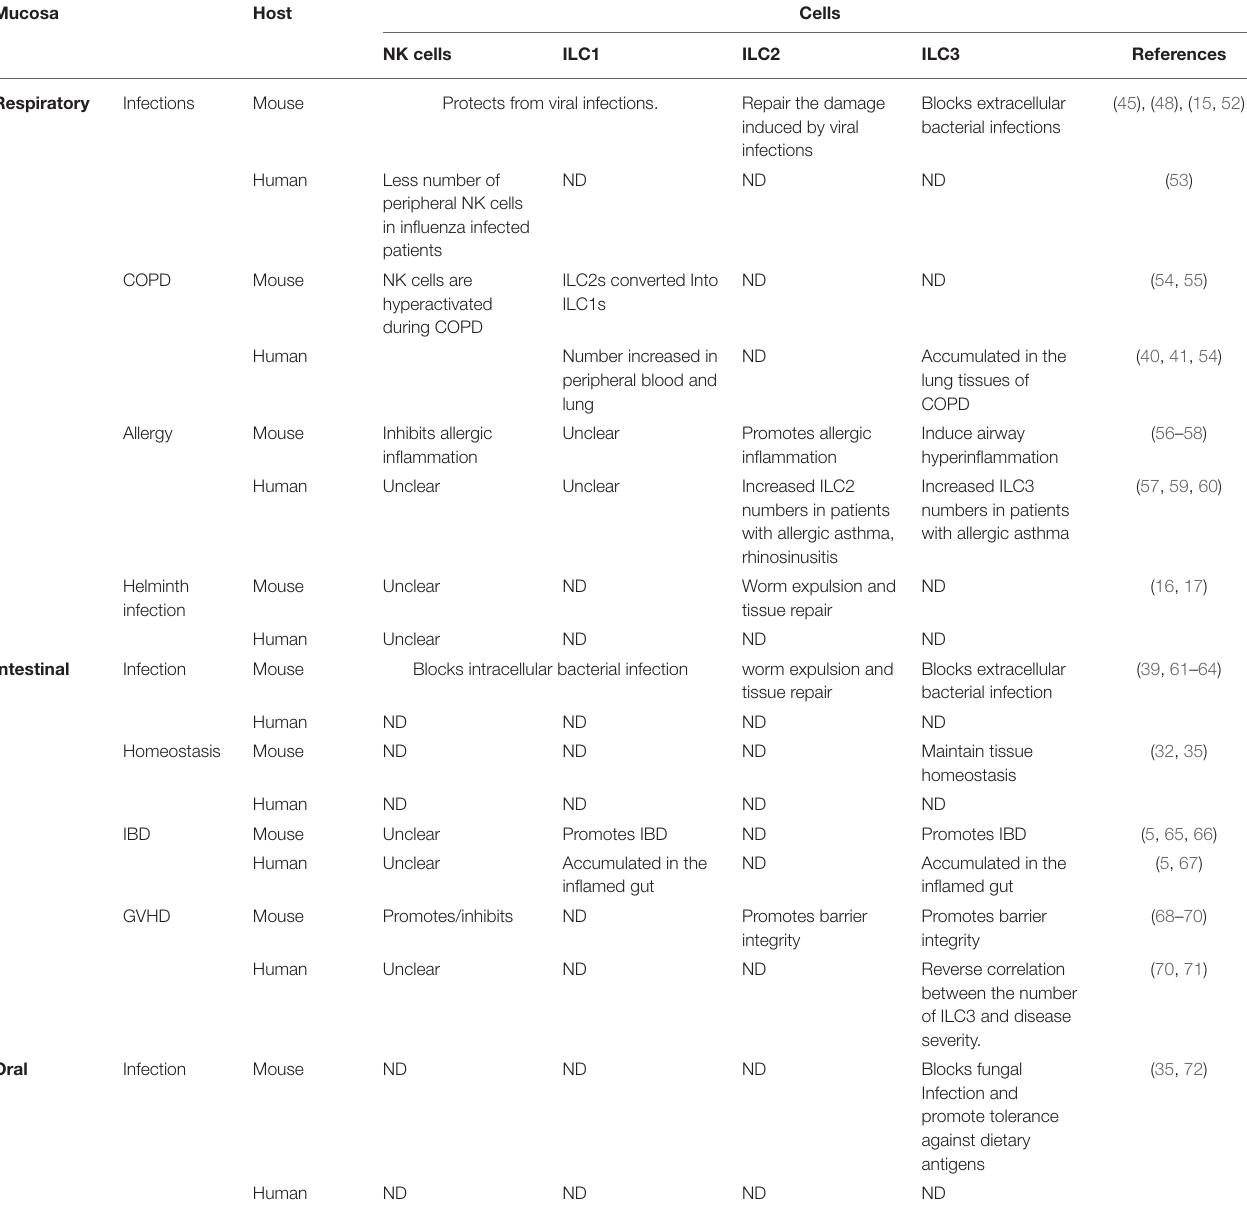
TABLE 1 | Role of ILCs in different mucosa of humans and mice.